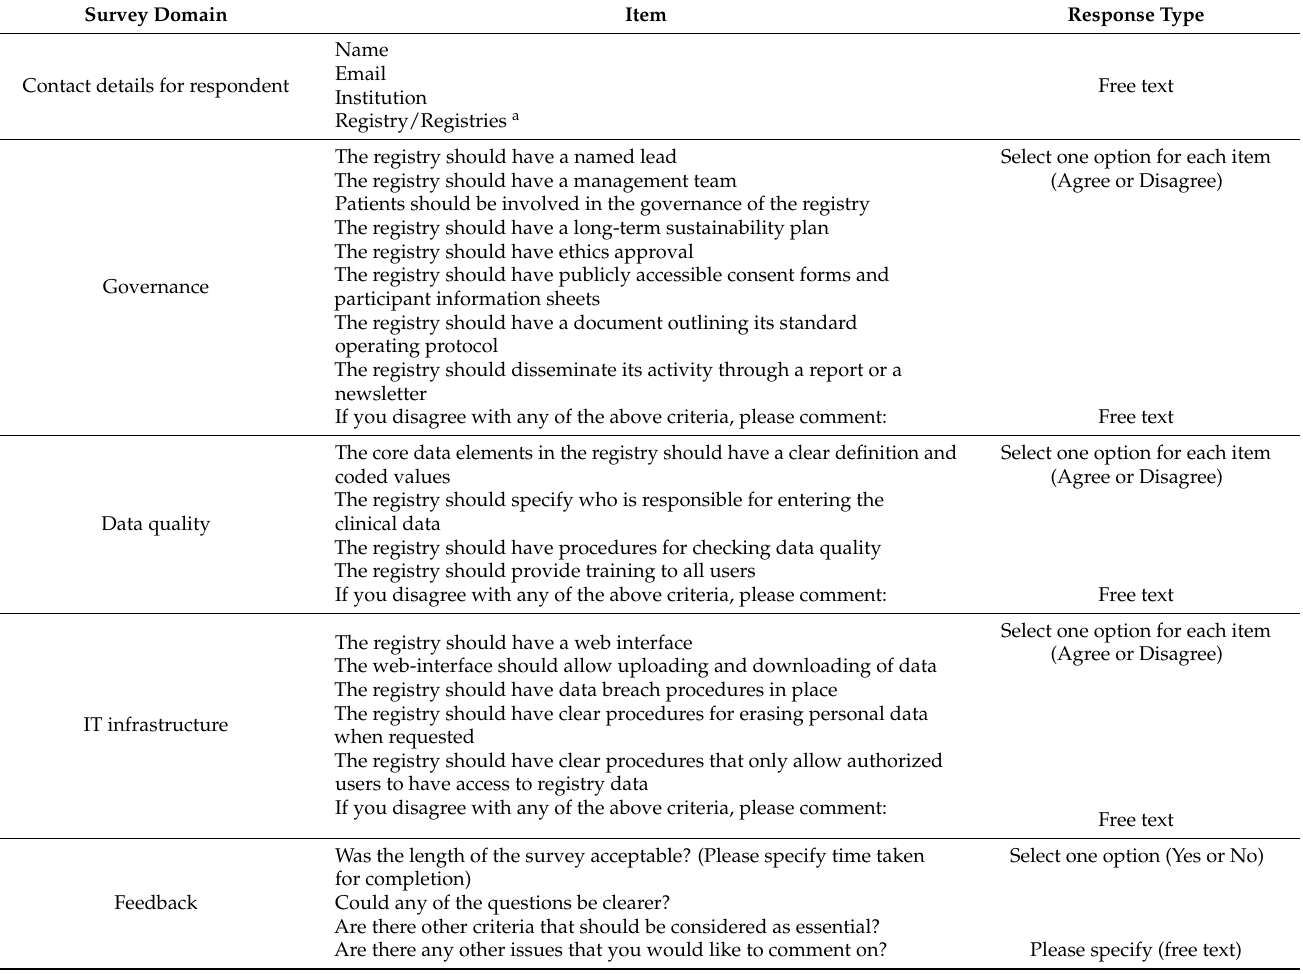
Table 1. Questionnaire